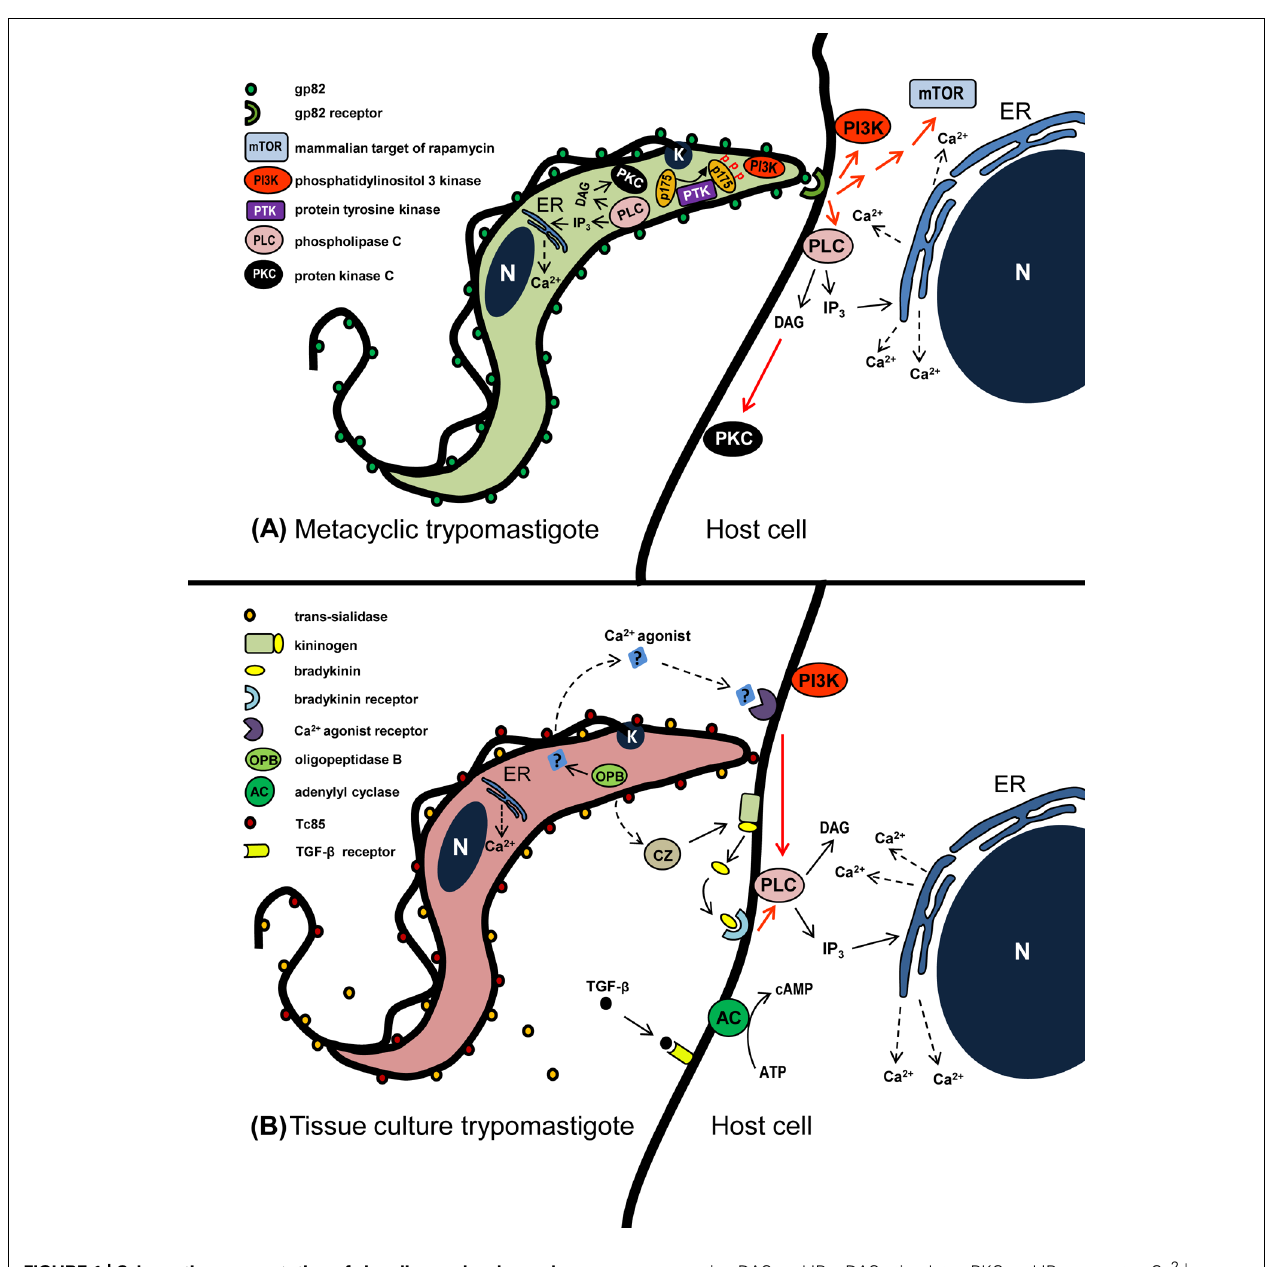
generating DAG and IP 3 . DAG stimulates PKC and IP 3 promotes Ca 2 + release from endoplasmic reticulum (ER). (B) DuringTCT interaction with host cells, a Ca 2 + agonist generated by parasite OPB binds to its receptor and triggers PLC activation.Then IP 3 -mediated Ca 2 + release from ER ensues. Bradykinin, produced from kininogen by the action ofTCT cruzipain, binds to bradykinin receptor and triggers PLC activation. Red arrows indicate activation, possibly not directly, but through as one or more as yet undefined